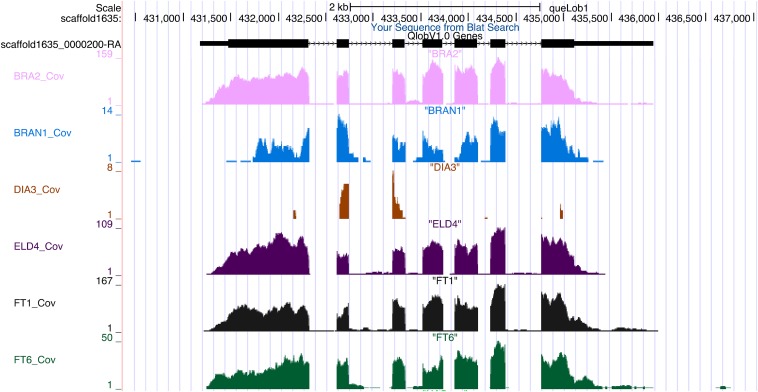
View of a cysteine-rich receptor-like protein kinase 29 gene in Q. lobata. The gene model is shown at the top, and below are the tracks for the expression of these gene across different trees, shown as counts of RNA-seq reads. The gene has a stress/antifungal domain, and exhibits low expression in one of the trees (DIA3), demonstrating that the expression of this locus is variable across trees (see https://valleyoak.ucla.edu/genomicresources/).